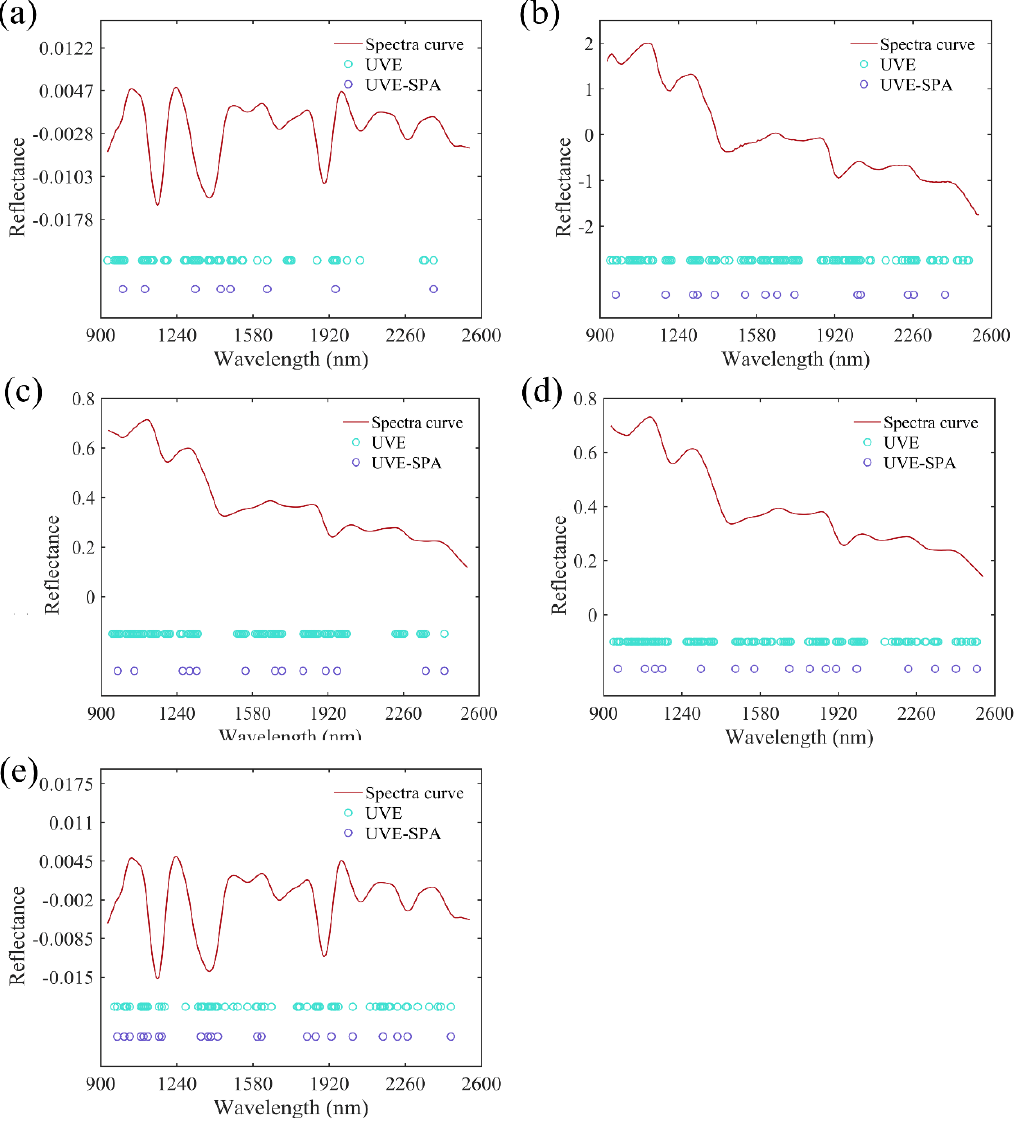
Figure 5. The selection results of feature wavelengths based on UVE and UVE − SPA. ( a ) S1 spectra were pretreated by SG − 1Der, ( b ) S2 spectra were pretreated by SG − SNV, ( c ) S3 spectra were pretreated by SG − MSC, ( d ) S1+S2 spectra were pretreated by SG − MSC, and ( e ) S1+S2 spectra were pretreated by SG − 1Der.